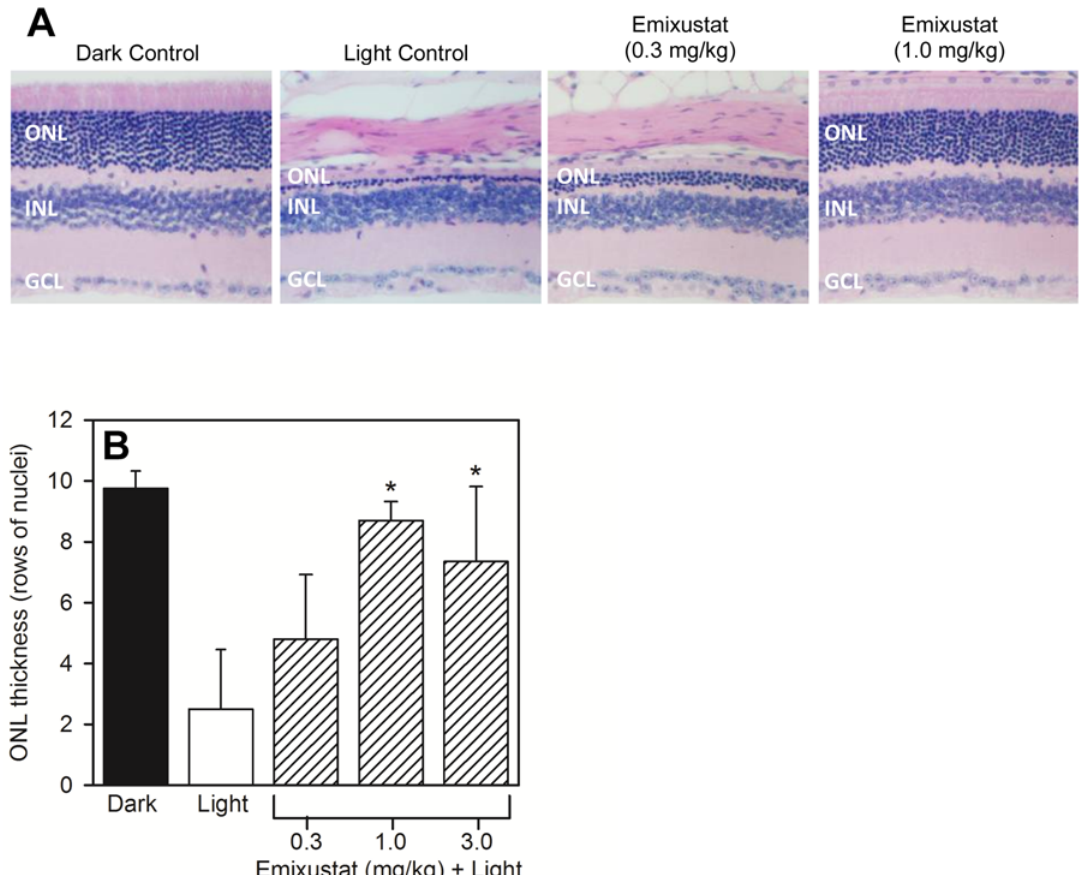
Fig 4. Protection from Light Damage. The ability of emixustat to provide protection from light damage was assessed as described in Methods . Mice received a single dose of emixustat, or vehicle, prior to light exposure (8,000 lux white light, 1 hour). Histological analyses and determination of ONL thickness was performed following a 2-week recovery period. Panel A shows tissue sections prepared from untreated, dark-adapted mice, untreated light- exposed mice, and mice pre-treated with either 0.3 or 1.0 mg/kg emixustat (ONL, outer nuclear layer; INL, inner nuclear layer; GCL, ganglion cell layer). Quantitative analysis of ONL layer thickness (panel B) was used to calculate the ED 50 for preservation of the ONL in emixustat-treated mice (ED 50 = 0.20 mg/ kg). There was a statistically significant preservation of ONL thickness in mice treated with 1.0 or 3.0 mg/kg emixustat compared to the vehicle-treated, light control group ( * , p <